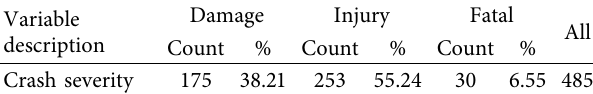
Table 1: Summary of crash severity